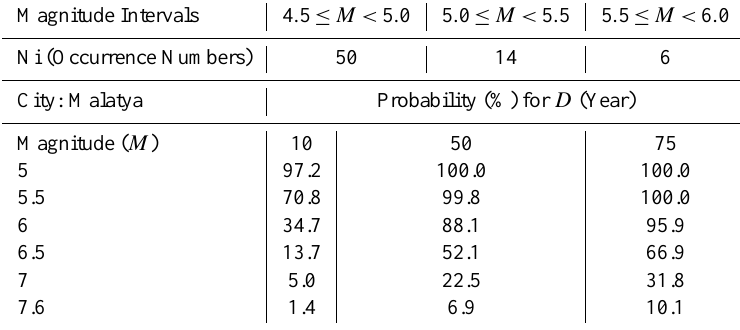
Table 3r. Earthquake occurrence probability (%) for D (Year) for Malatya city.